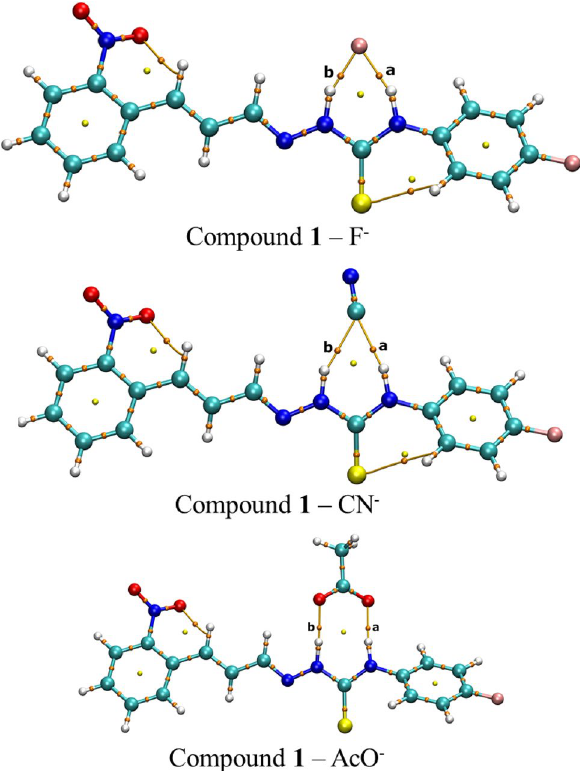
Figure 16. AIM molecular graphs of optimized geometries with B3LYP-D3/6–311 + (d,p)/SMD method of compounds 1 – 6 complexed with anion F − . Tiny orange spheres (BCPs), tiny yellow spheres (RCP) and orange lines (BPs). H atoms (white spheres), C atoms (light blue spheres), N atoms (blue spheres), O atoms (red spheres), F atoms (pink spheres), and S atoms (yellow spheres).